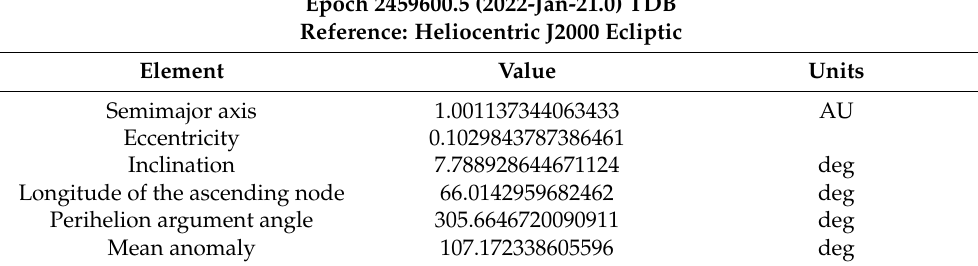
Table 1. Orbit elements of 2016HO3.